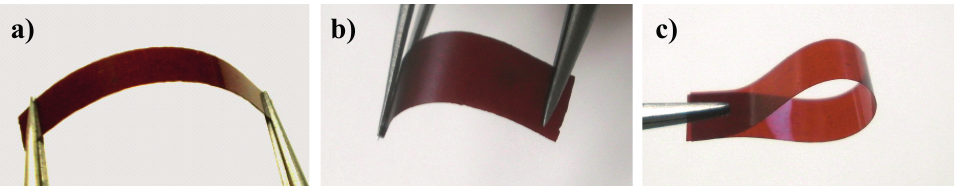
Figure 10. Appearance of cured films of PP-4va ( a ), P(P-4va/MMA) ( b ), and P(P-4va/BuA) with 33 mol % of BuA composition ( c